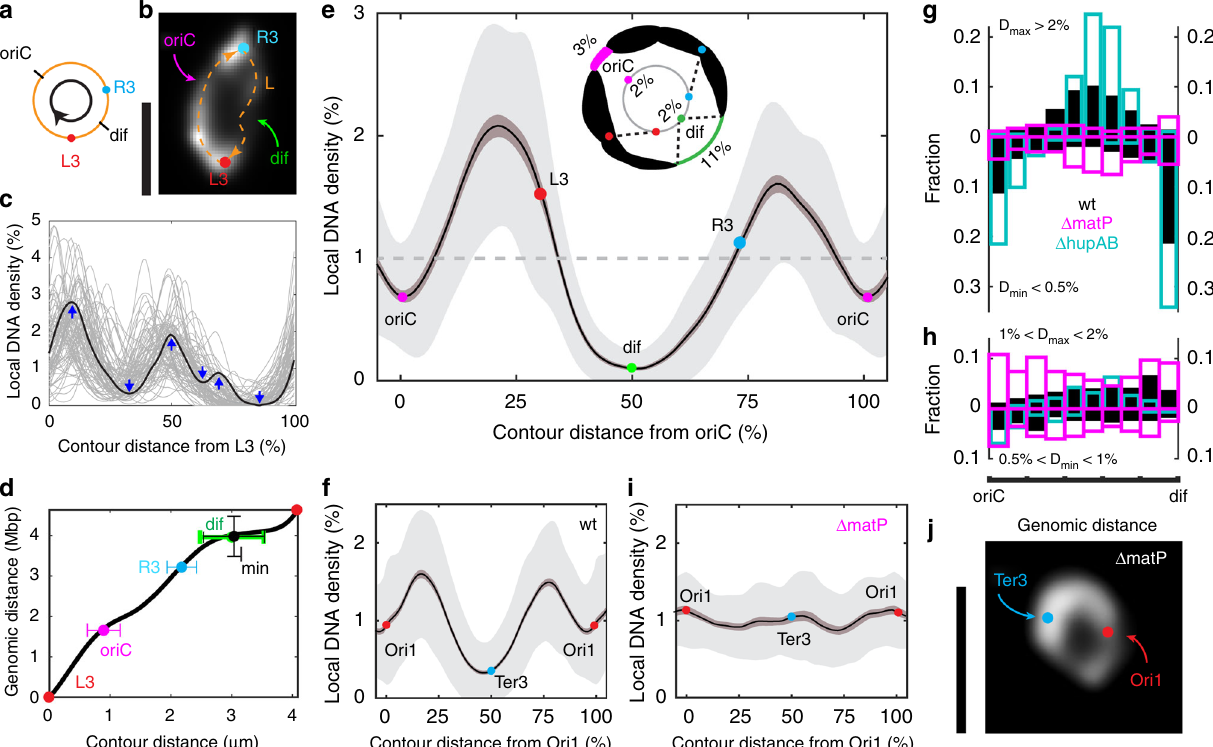
Fig. 3 DNA density mapping along the circular E. coli genome. a Schematic of the E. coli genome with two FROS markers at the left and right arms shown in b-e. The arrow indicates the direction of density mapping. b Example of a circular chromosome as indicated in A, with the HU-mYPet fl uorescence intensity shown in grey scale (deconvolved image). Scale bar, 2 μ m. c Local DNA density along the ridge line of single circular chromosomes plotted as a function of percentile distance from L3. Each line indicates a single chromosome. An example chromosome density is highlighted in black. Blue arrows indicate local maxima (peaks) and local minima (valleys) in this example curve. n = 82. d Average cumulative density function mapping the genomic coordinates to the contour coordinates along the ridge of the circular chromosome. Marks indicate the measured positions of the R3 locus and global minimum I min , and the predicted positions of oriC and dif sites. Error bars indicate s.d. e Local DNA density plotted versus genomic coordinate in percentile distance along the ridge line from the predicted oriC sites, with mean values and positions of dif , L3 and R3 indicated. Dark and light shading indicates s.e.m and s.d. Inset: schematic illustrating the DNA density distribution along a typical circular E. coli chromosome as concluded from the blob analysis and contour density analysis. n = 292. f DNA density distribution of a second independent strain with Ori1/Ter3 labels, plotted as in panel e . Note that in this strain left and right arms can be distinguished less well due to symmetry (Fig. 1a). n = 74. g , h Distributions of local maxima (plotted upwards) and local minima (downwards) in the DNA intensity within individual chromosomes along the genomes from oriC to dif site. Bin size 5% of the genome length (230kbp). Local maxima and minima are identi fi ed as in c . ‘ D ’ denotes local DNA density. i DNA density distribution of a Δ matP strain with Ori1/Ter3 labels, plotted as in panel e . j Example of a circular chromosome in a Δ matP cell, with the HU-mYPet fl uorescence intensity shown in grey scale (deconvolved